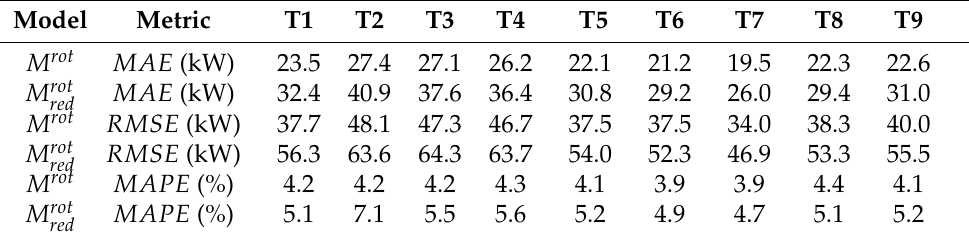
Table 9. Results of the models validation for the rotor speed—power curve in Region 2: WF2. Model